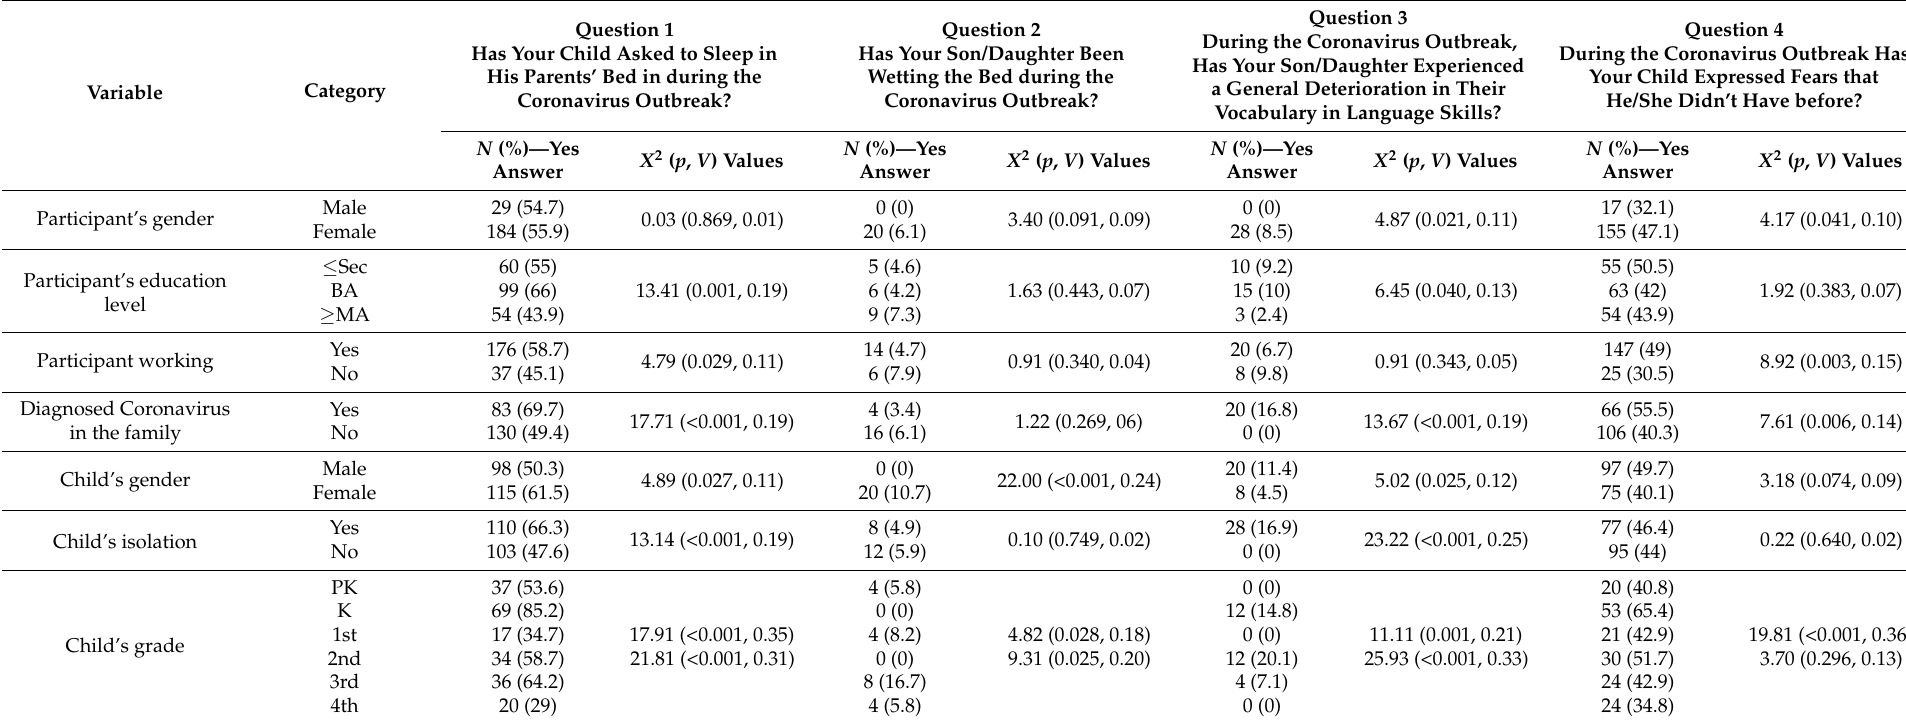
Table 3. Participants’ answers to the regressive behavior area questions by the study